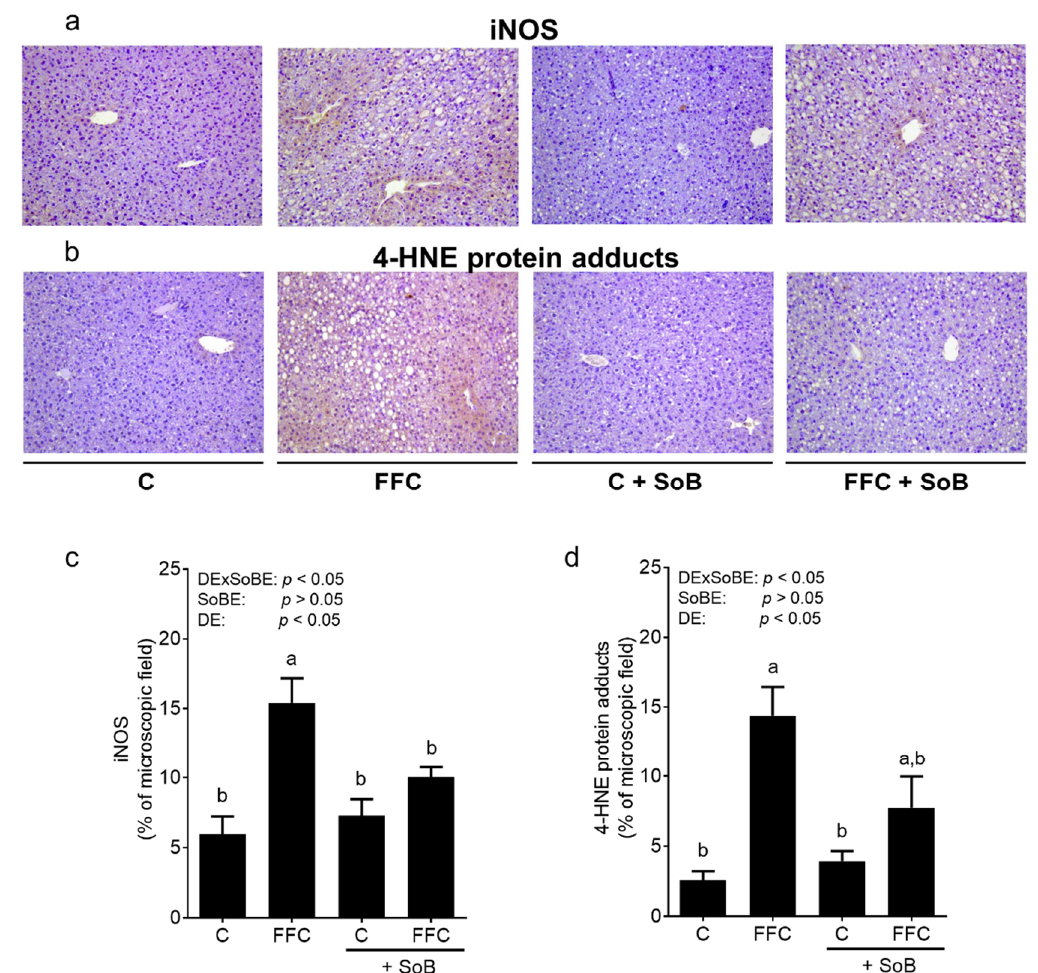
Figure 4. E ff ect of supplementation of SoB on lipid peroxidation in livers of mice with FFC-induced NASH. Representative photomicrographs of ( a ) inducible nitric oxide synthase (iNOS) and ( b ) 4-hydroxynonenal (4-HNE) protein adducts staining in para ffi n embedded tissue (magnification 200 × ) as well as densitometric analysis of ( c ) iNOS and ( d ) 4-HNE protein adducts staining in liver tissue. Data are expressed as means ± SEM, n = 8. Data with di ff erent letters are significantly di ff erent, p < 0.05. C, control diet; DE, diet e ff ect; DExSoBE, interaction between diet and SoB; FFC, fat-, fructose-, and cholesterol-rich diet; NASH, non-alcoholic steatohepatitis; SoB, sodium butyrate; SoBE; sodium butyrate e ff ect.